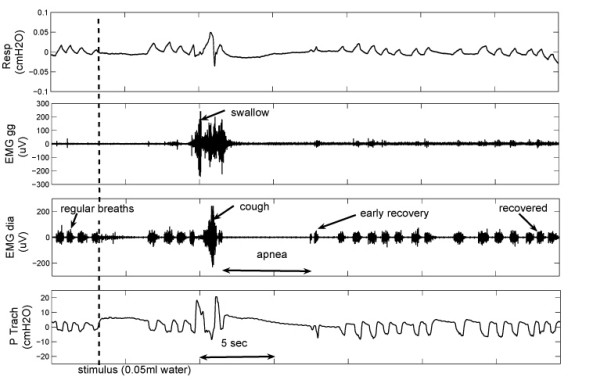
Typical tracings during the LCR in a 10 days old piglet. Example of the events undergoing during the LCR. After the stimulus, swallowing is visible on the EMGgg tracing and coughing is visible on the EMGdia. Apnea results in the cessation of respiratory activity and this is visible on all channel.